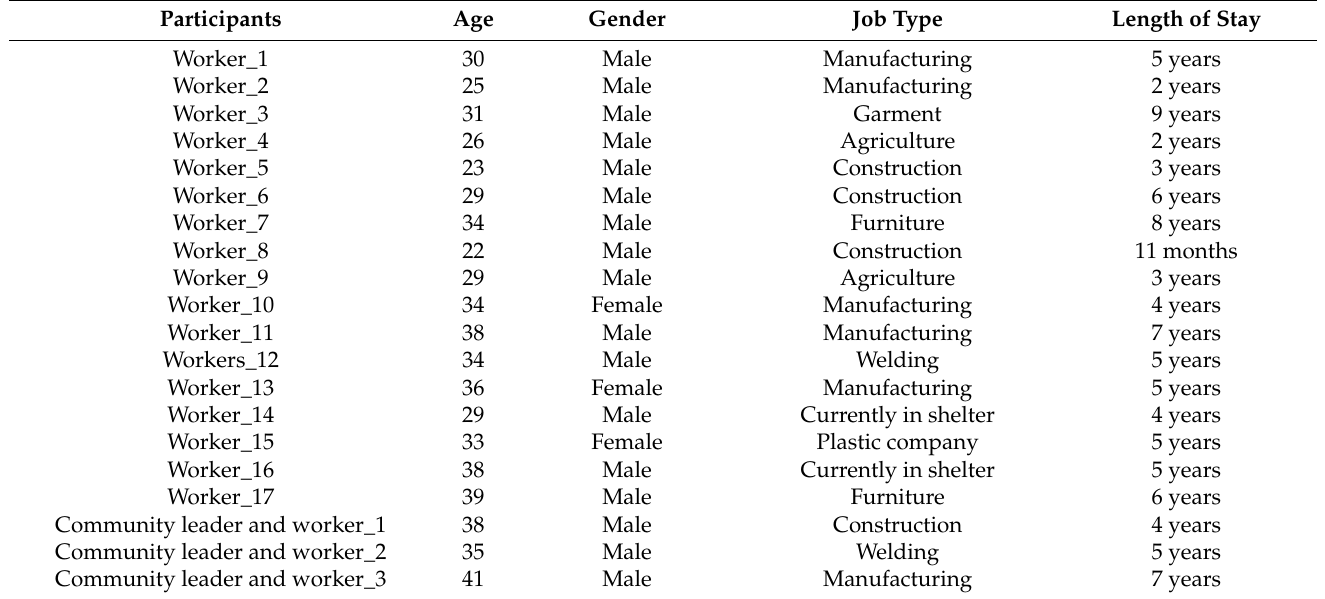
Table 1. Demographic characteristics of the participants ( n =